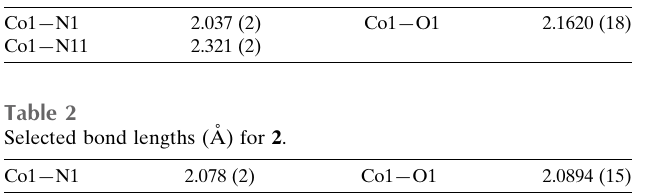
Table 1 Selected bond lengths (A˚ ) for 1 .